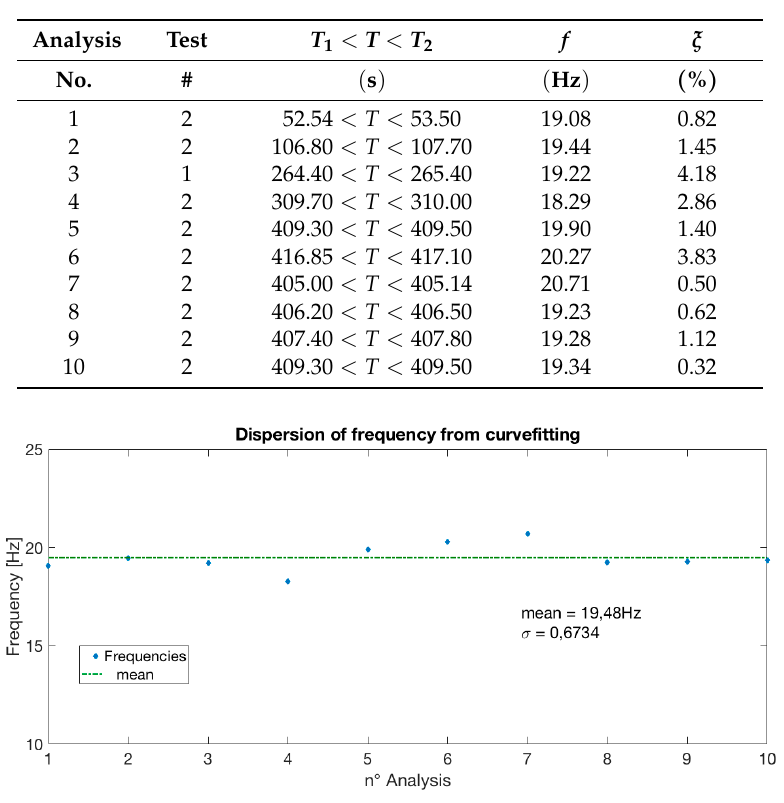
Figure 13. Dispersion of data.